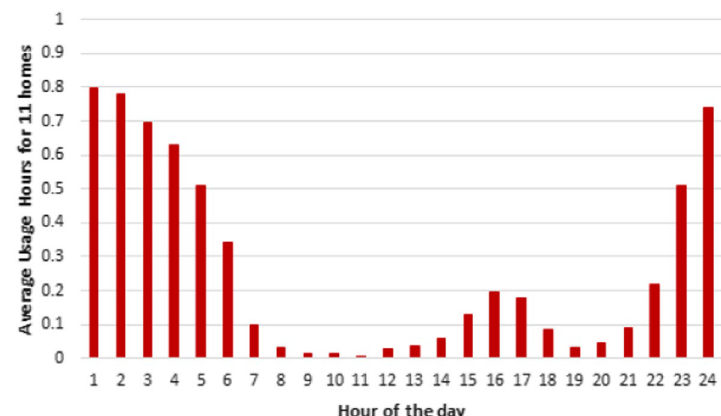
Fig. 9 Average AC usage hours per day of 11 homes for 19